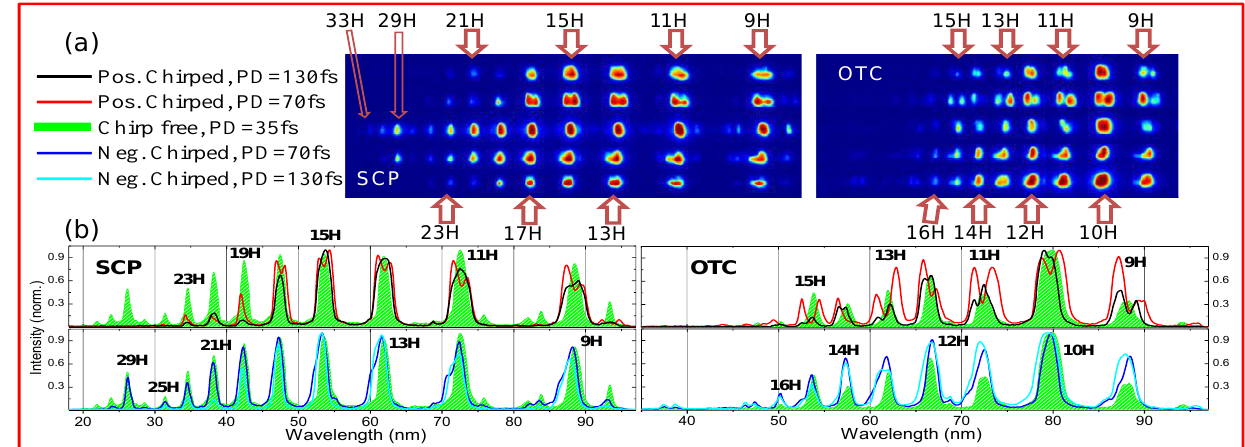
Figure 9. HHG for Cr 3 C 2 NP LIP with chirped and chirp-free SCP and OTC. Panel ( a ) shows raw MCP images for SCP and OTC using 0.2 mm BBO crystal. Panels ( b ) present profile plots for corresponding images.